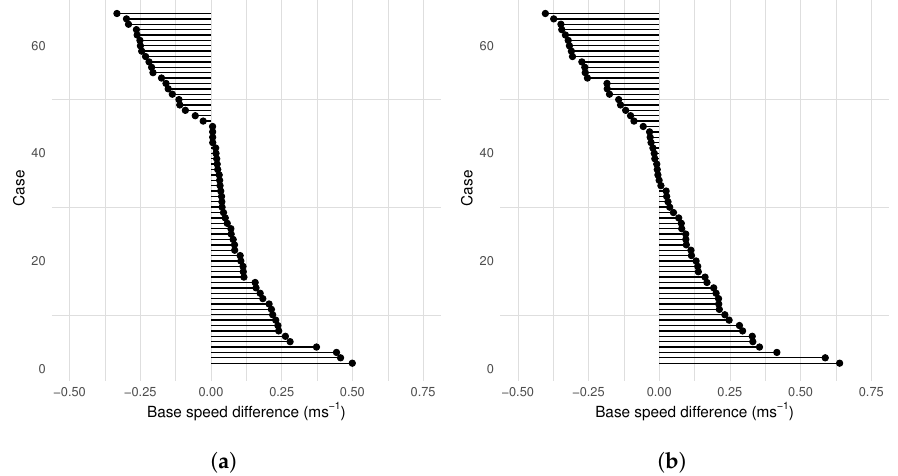
Figure 17. Difference in base speed values estimated and measured for ( a ) DF and ( b ) VW.